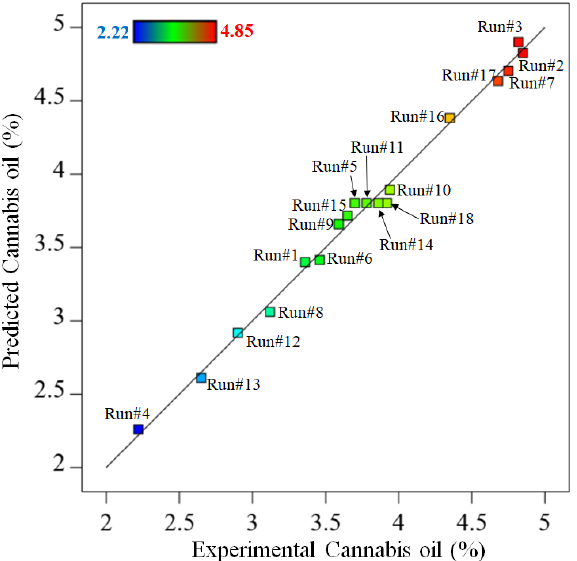
Figure 1. Parity plot between the experimental and predicted cannabis oil